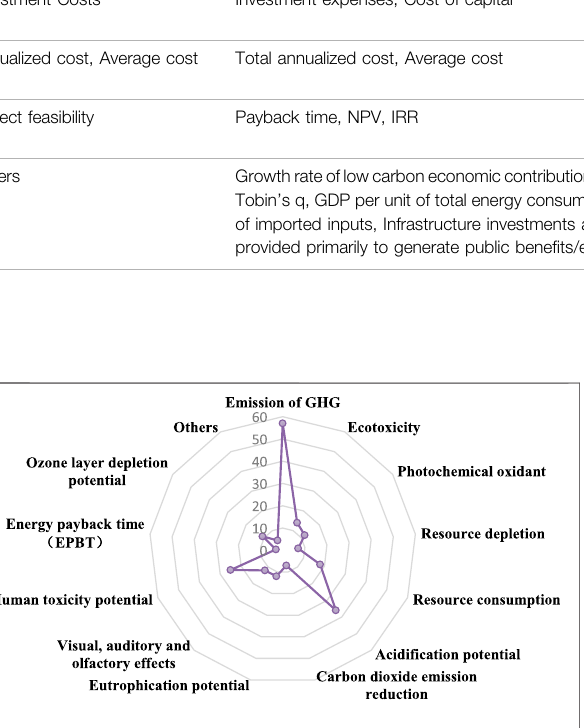
FIGURE 7 | Classi fi cation and frequency of environmental sustainability